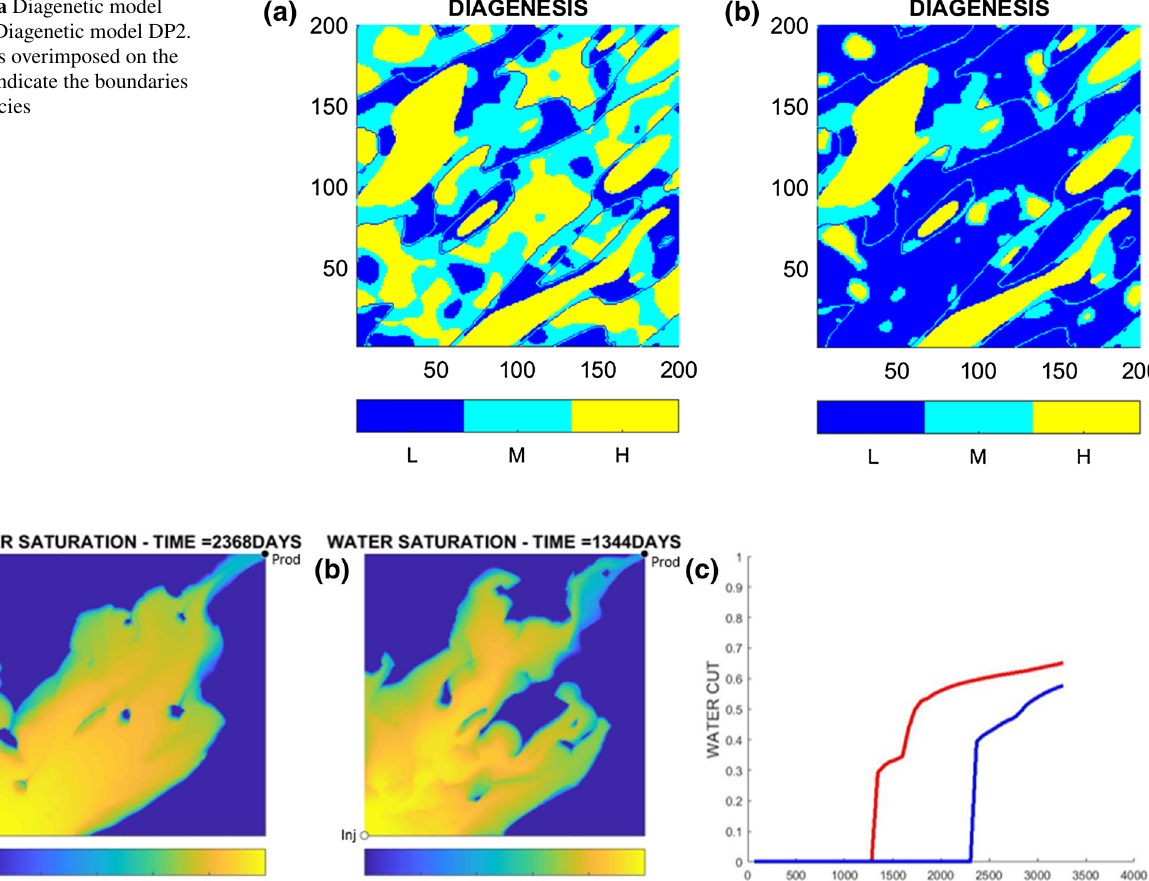
Fig. 12 a Diagenetic model DP1. b Diagenetic model DP2. The lines overimposed on the figures indicate the boundaries of the facies